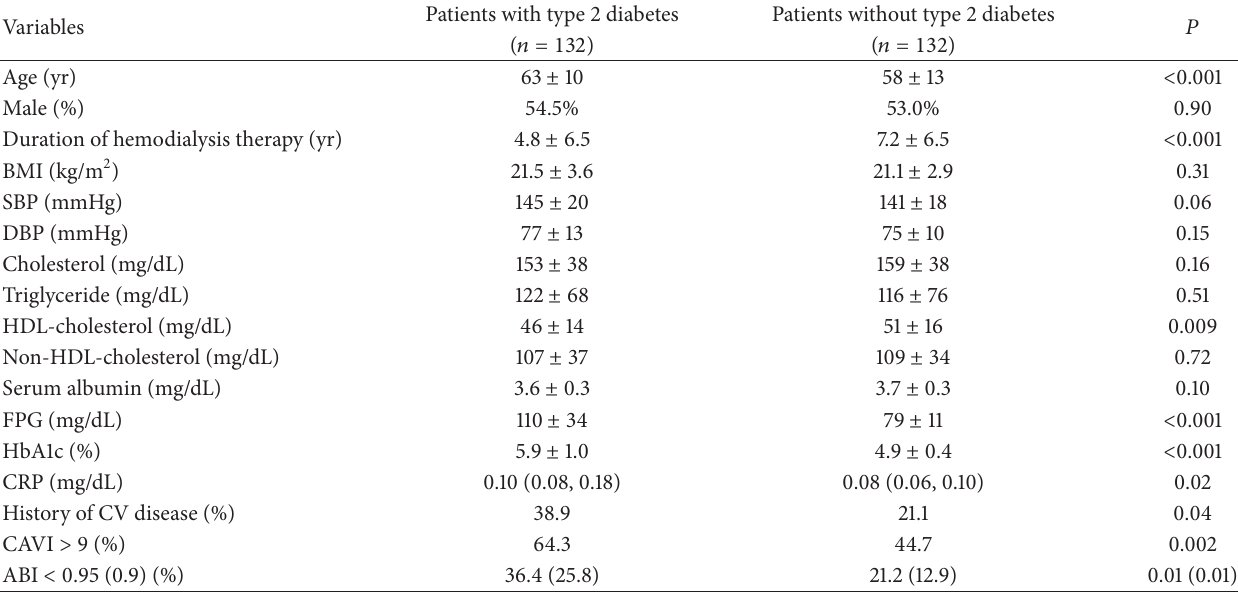
Table 1: Comparison of clinical and biochemical characteristics between hemodialysis patients with or without type 2 diabetes.